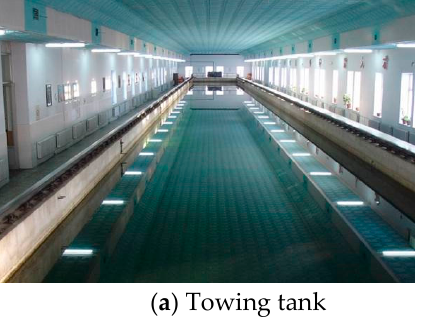
Figure 7. Experimental facilities.